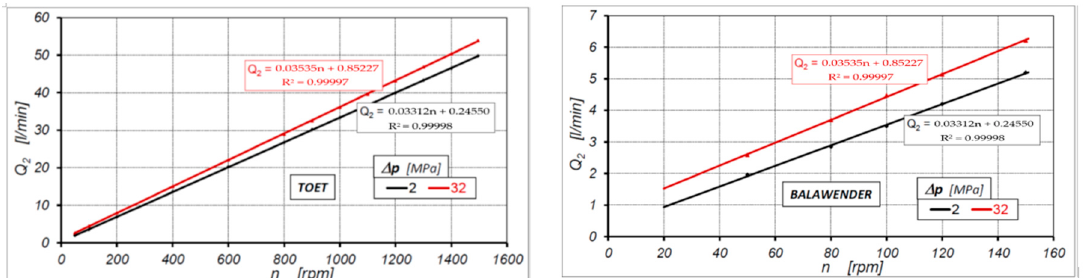
Figure 10. Characteristics of motor output flow rate Q 2 as a function of rotational speed n at Δ p = const. On the left—Toet’s method; on the right—Balawender’s method.